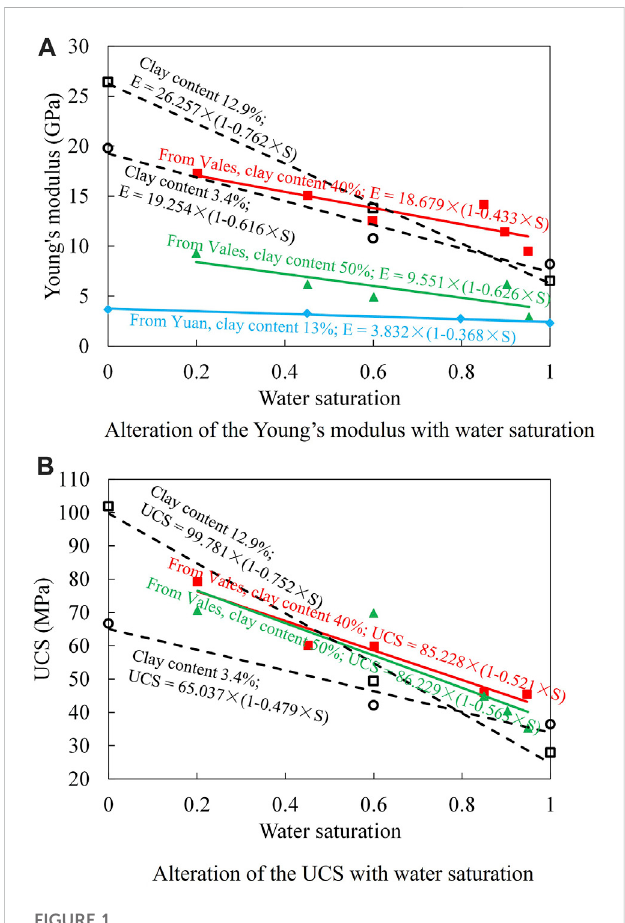
FIGURE 1 Alteration of geomechanical properties with water saturation (Experimental data cited from Yuan et al. (2014); and Valès et al. (2004); datawithblackblanksymbolsweredatafromthisstudy). (A) Alterationof theYoung ’ smodulus (B) AlterationoftheUCSwithwatersaturation with water